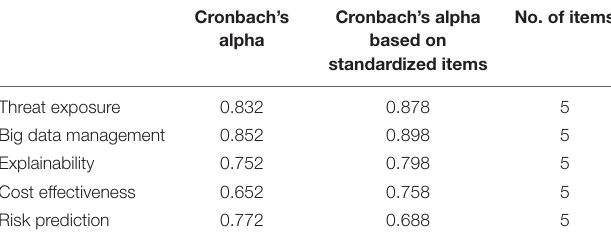
TABLE 2 | Reliability statistics AI